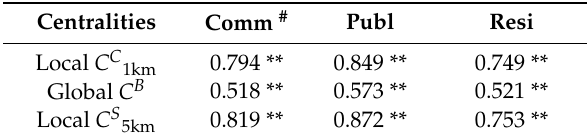
Figure 11. Spatial distributions of street centralities and land use intensities at the subdistrict level (census block) in Shenzhen City. ( a ) Closeness at 1 km searching radius, ( b ) Commercial land use intensity, ( c ) Global Betweenness, ( d ) Public service land use intensity, ( e ) Straightness at 2 km searching radius, ( f ) Residential land use intensity. Table 3. Pearson’s r between street centralities and land use intensities at the subdistrict level (census block) (N = 58).